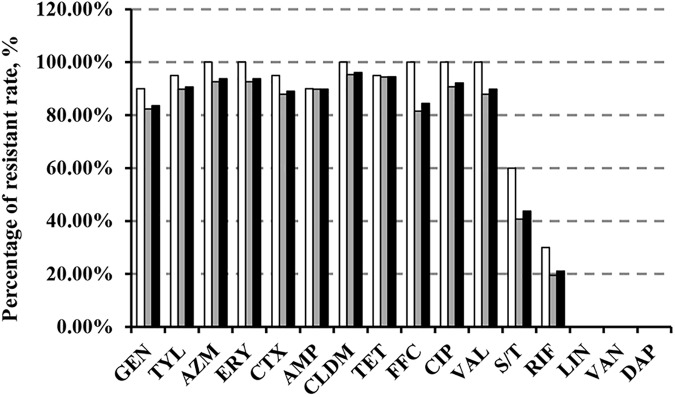
Antibiotic resistance in MRSA strains from animals and humans. GEN, gentamicin; TYL, tylosin; AZM, azithromycin; ERY, erythromycin; CTX, cefotaxime; AMP, ampicillin; CLDM, clindamycin; TET, tetracycline; FFC, florfenicol; CIP, ciprofloxacin; VAL, valnemulin; S/T, sulfamethoxazole/trimethoprim; RIF, rifampicin; LIN, linezolid; VAN, vancomycin; DAP, daptomycin.